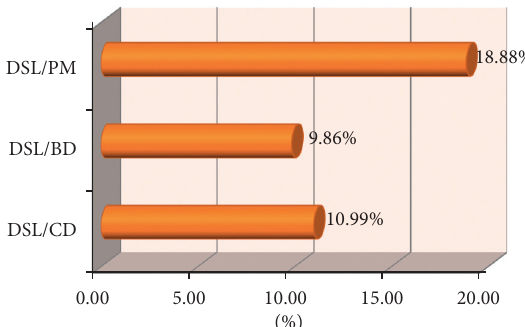
Figure 9: Ash content of the briquettes with different binders.